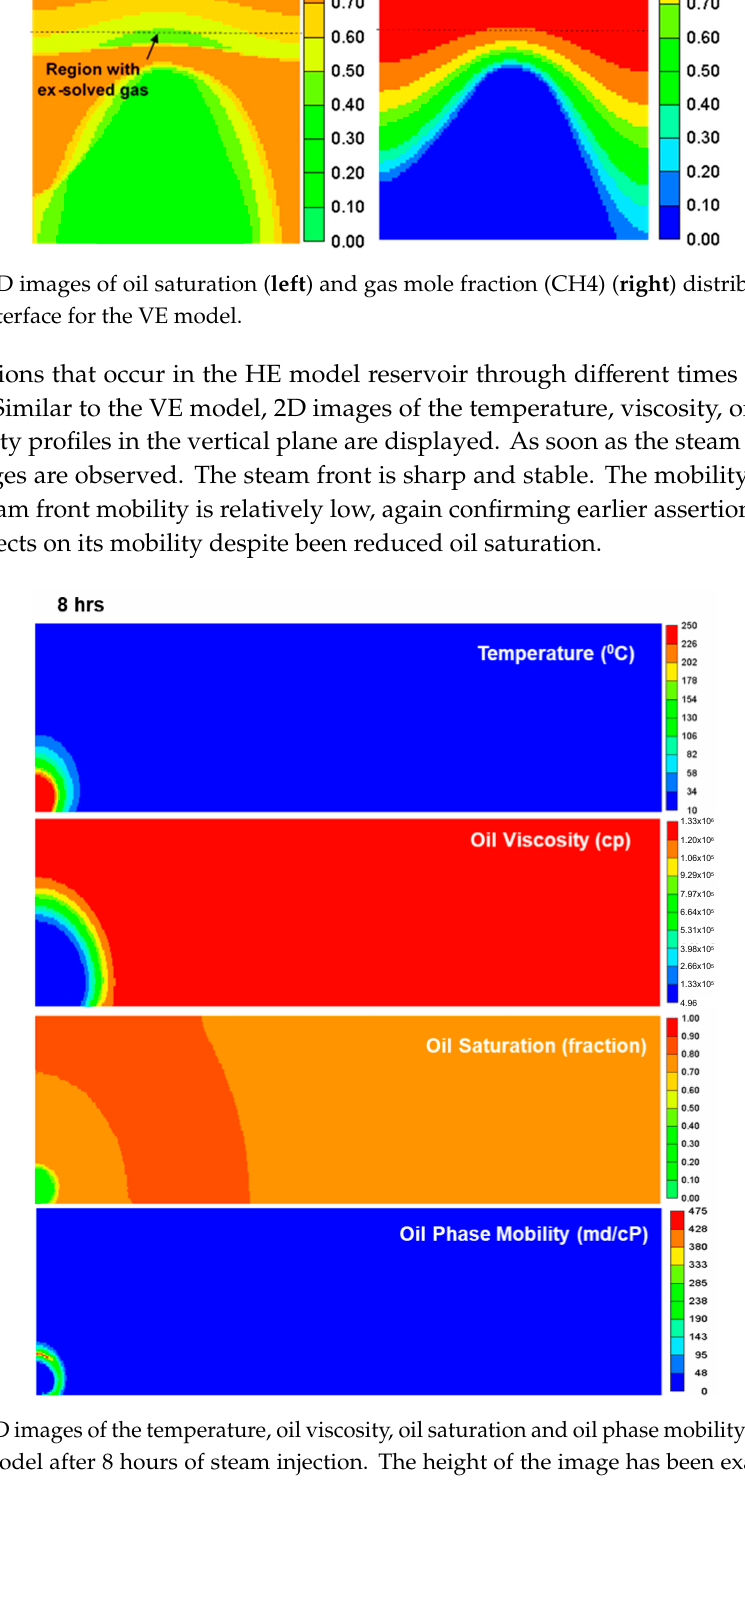
Figure 20. 2D images of the temperature, oil viscosity, oil saturation and oil phase mobility distributions of the VE model after 12 days of steam injection. Zoomed in views are displayed of the region enclosed by the dashed black line square.